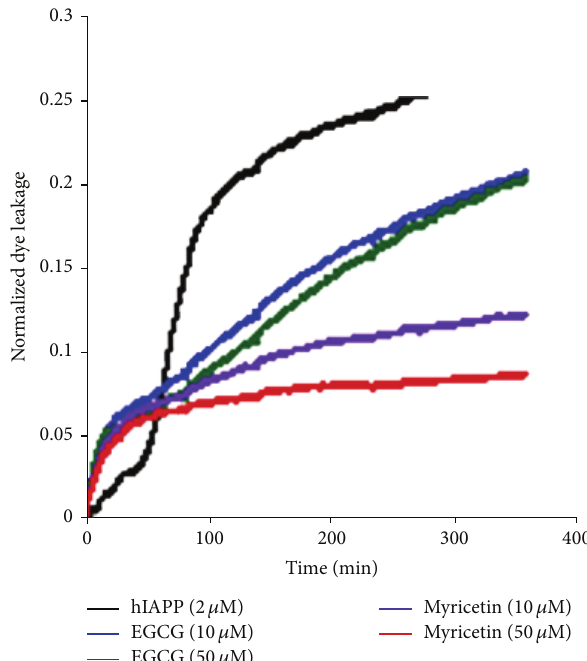
Figure 5: Dye leakage induced upon hIAPP addition (2 𝜇 M) to 0.2 mg/mL POPC/POPG (7: 3 molar ratio) lipid vesicles in the presence and absence of indicated flavanols. Membrane disruption is detected by concentration dependent quenching of a vesicle- encapsulateddye.Withinthevesicle,thecarboxyfluoresceindyeisat a high concentration and is quenched. Disruption of the membrane integrity of the vesicle dilutes the concentration of the dye and thereby increases the measured